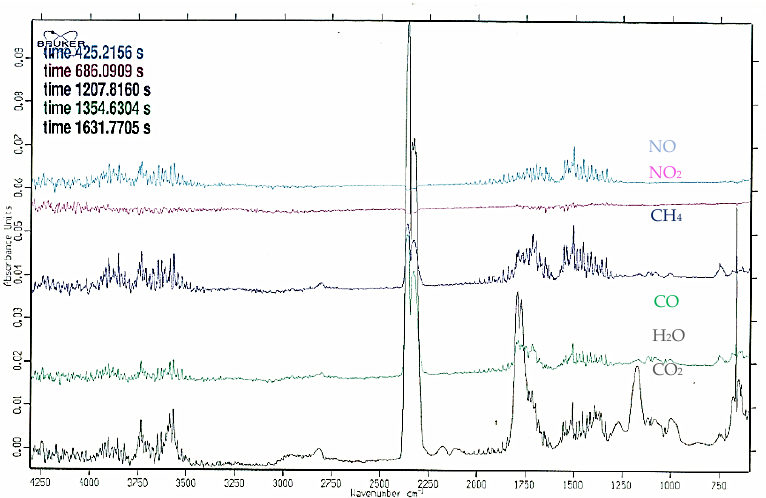
Figure 5. FTiR analysis of Jerusalem artichoke torrefaction by-products: torgas during the torrefaction process under 245 °C.